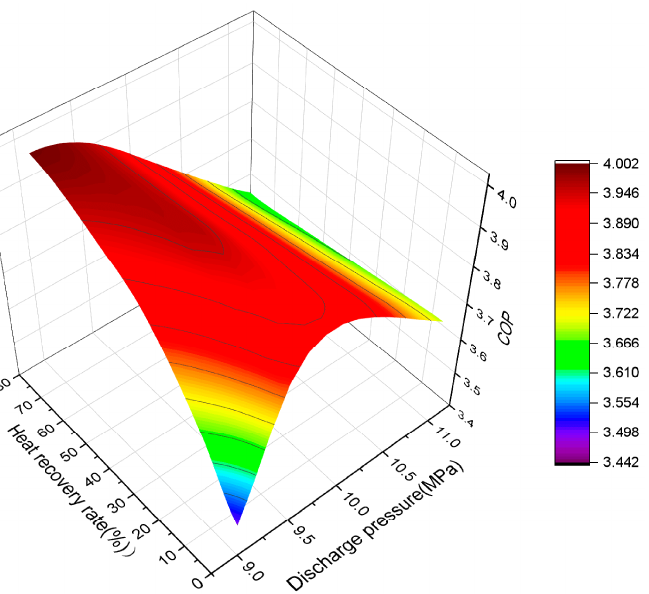
Figure 6. The collaborative optimization of the discharge pressure and heat recovery rate under 10 ° C in ambient temperature.